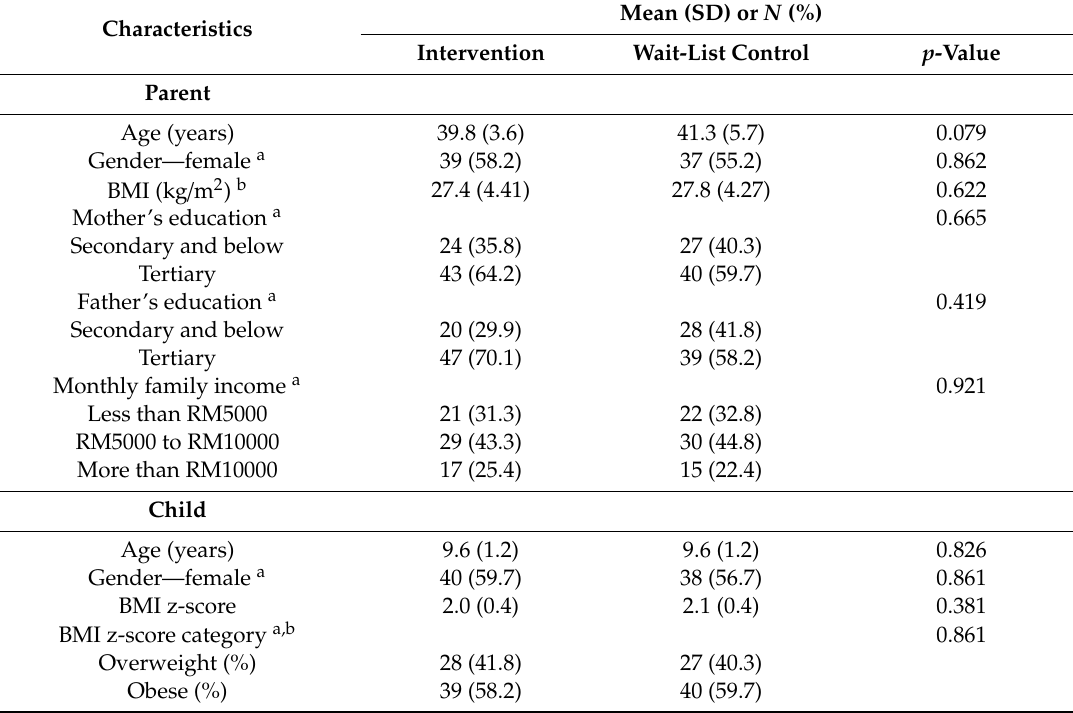
Table 3. Baseline characteristics of 134 parent-dyads allocated to the intervention or wait-list control group. Characteristics